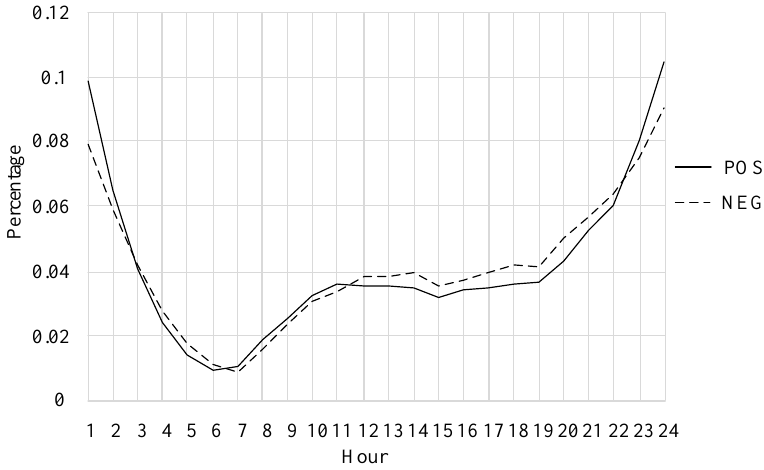
Figure 4. Time distribution of interaction.